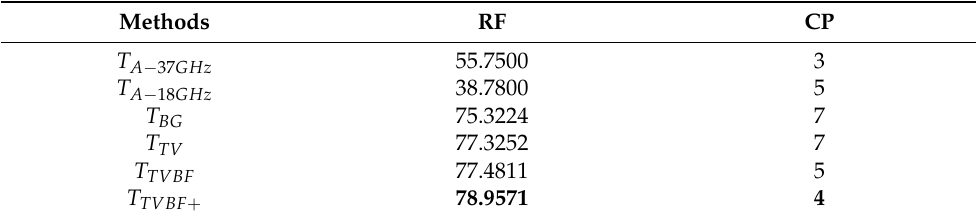
Table 5. The evaluation indices of the actual scenario.